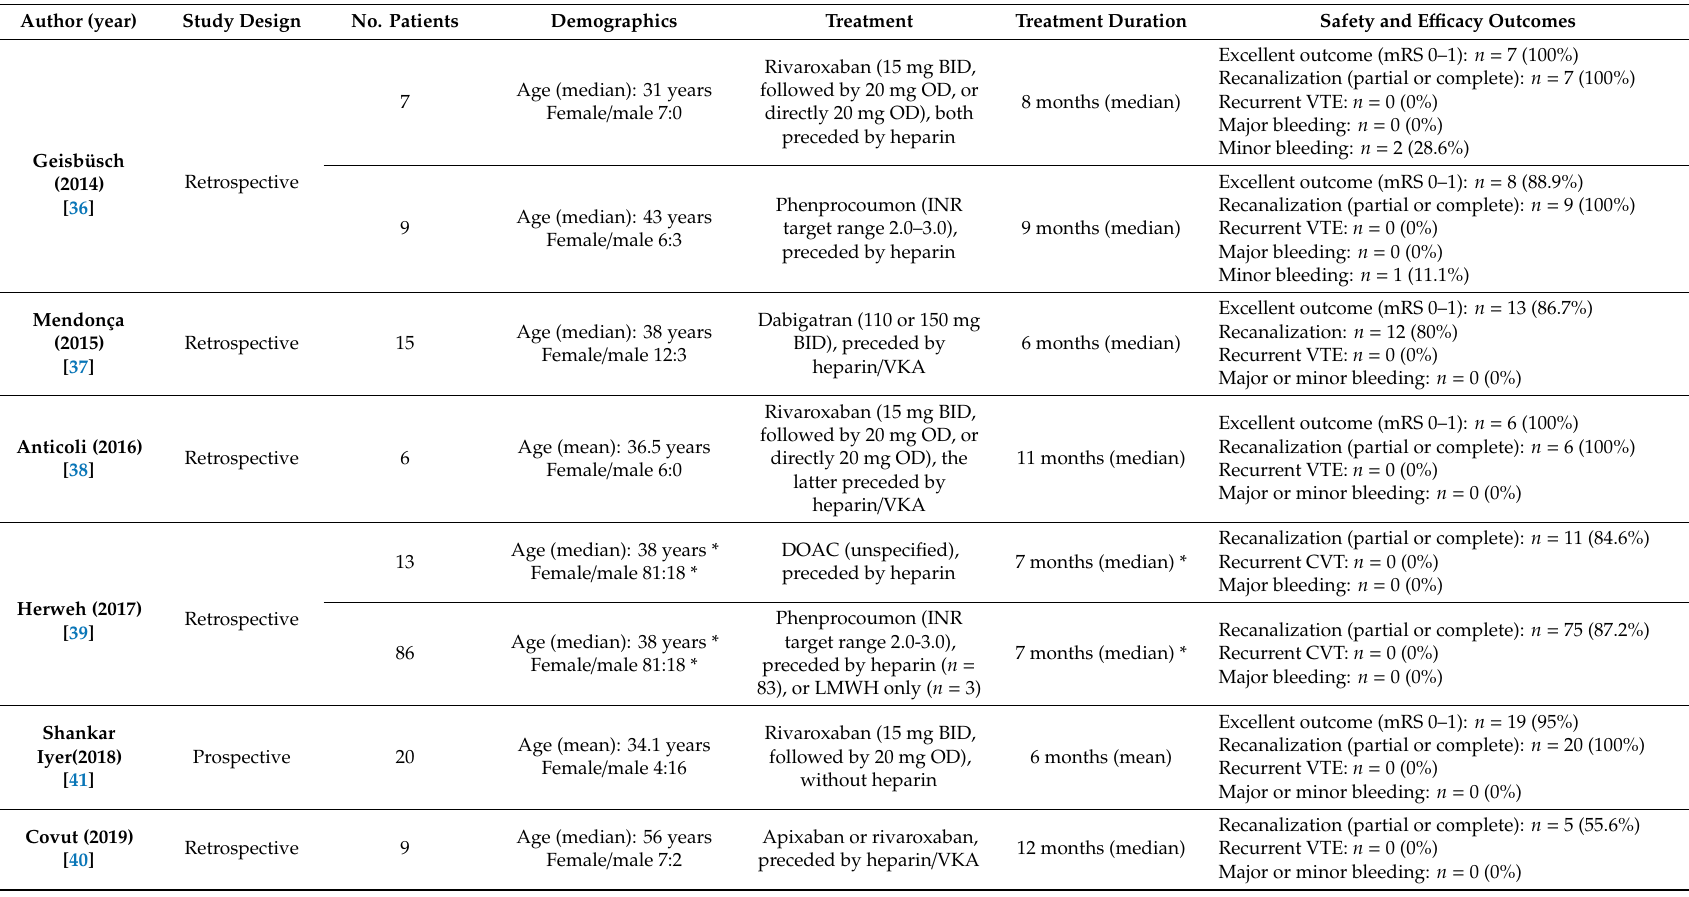
Table 1. Studies evaluating the use of the direct oral anticoagulants in patients with cerebral vein